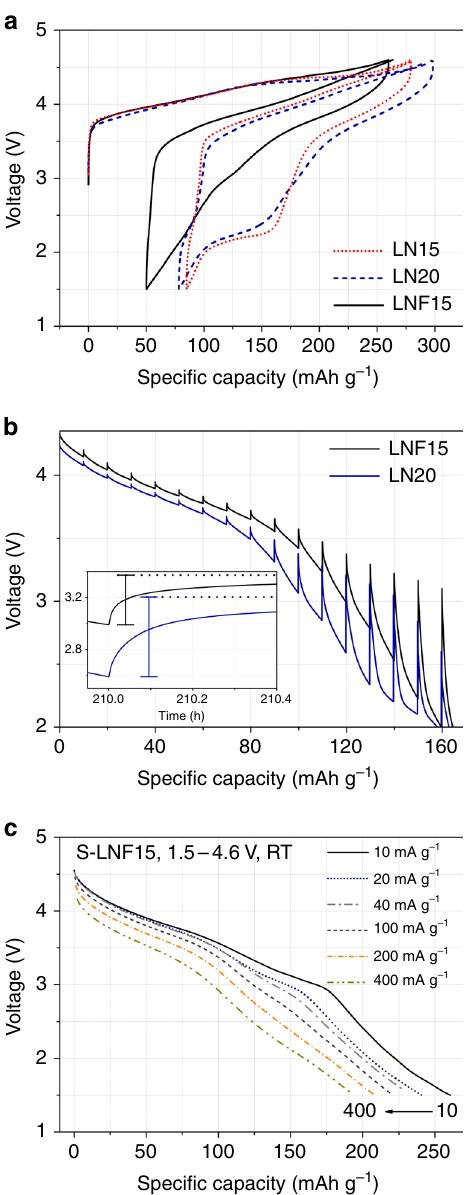
Fig. 5 Electrochemical analysis of the origin of the improved cycling performance upon fl uorine substitution. a Voltage pro fi les obtained upon fi rst- cycle and second-charge: Li 1.15 Ni 0.375 Ti 0.375 Mo 0.1 O 2 (LN15: red dot), Li 1.2 Ni 0.333 Ti 0.333 Mo 0.133 O 2 (LN20: blue dash), and Li 1.15 Ni 0.45 Ti 0.3 Mo 0.1 O 1.85 F 0.15 (LNF15: black solid). b First discharge voltage pro fi les of LN20 (blue) and LNF15 (black) from galvanostatic intermittent titration tests (GITT) after initial charge to 270mAhg – 1 : the inset shows the voltage – time GITT pro fi les around 120mAhg – 1 . Each step in GITT curve corresponds to a galvanostatic (dis) charge of an additional 10mAhg – 1 at a rate of 20mAg – 1 and is followed by a fi ve-hour relaxation step. c Discharge pro fi les of shaker-milled LNF15 (S-LNF15), when charged at 20mAg – 1 and discharged at different rates of 10, 20, 40, 100, 200, and 400mAg – 1 (1.5 – 4.6V,